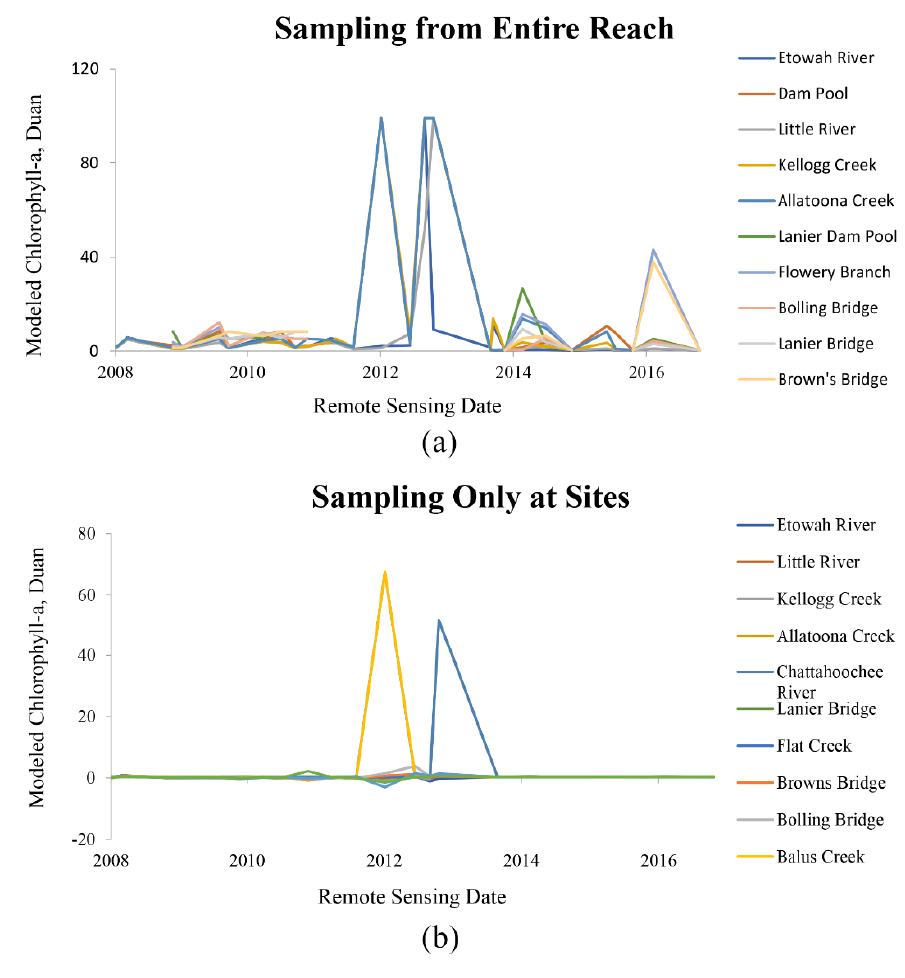
Figure A3. Both ( a ) reach-based and ( b ) point-based sampling of the modelled chlorophyll-a data show similar results using the Duan algorithm in Lakes Allatoona and Lanier. Table A1. Physical and Hydrological Characteristics of Lake Allatoona and Lake Sidney-Lanier. Characteristic Unit Lake Allatoona Lake Sidney-Lanier